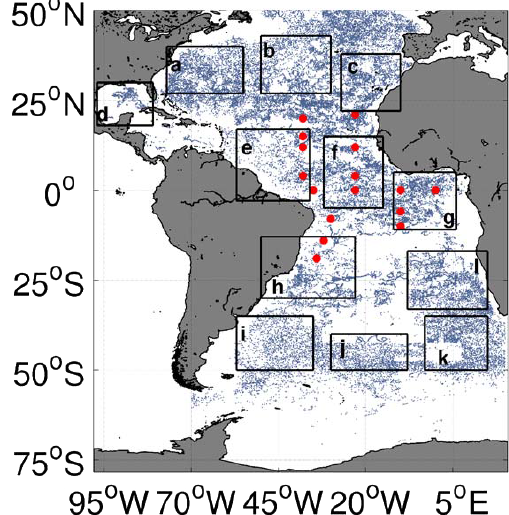
Figure 4. Locations of the 47999 valid Argo profiles (blue dots) as- similated and also used to validate the prior state of each experiment from 2010 to 2012 in the model domain (100 ◦ W–20 ◦ E, 78 ◦ S– 50 ◦ N), which excludes the Pacific Ocean, the Mediterranean Sea, and the North Atlantic subpolar region. The 16 fixed moorings from PIRATA used in the experiment’s validation are represented by red dots. The numbers of valid Argo profiles in the 12 sub-regions (a–l) were 3085, 2352, 2522, 540, 1463, 2750, 2475, 1849, 1560, 1597, 2536 and